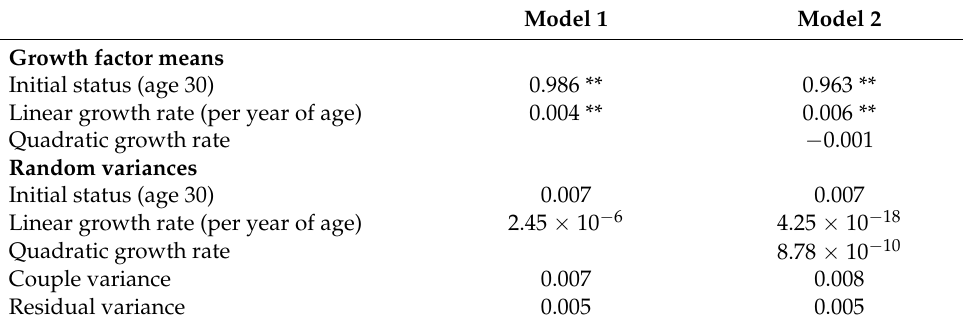
Table 2. Examination of linear and quadratic models of change in DunedinPACE as a function of age using Unconditional growth